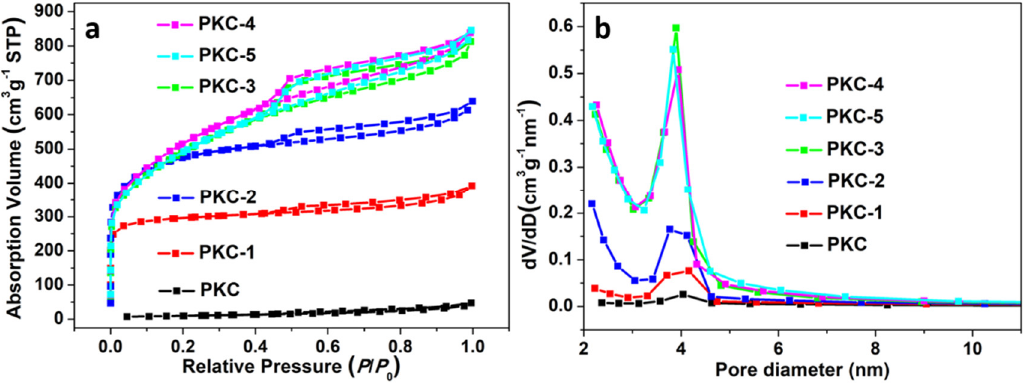
Figure 3. ( a ) Nitrogen adsorption−desorption isotherms and ( b ) pore size distributions of biochars.